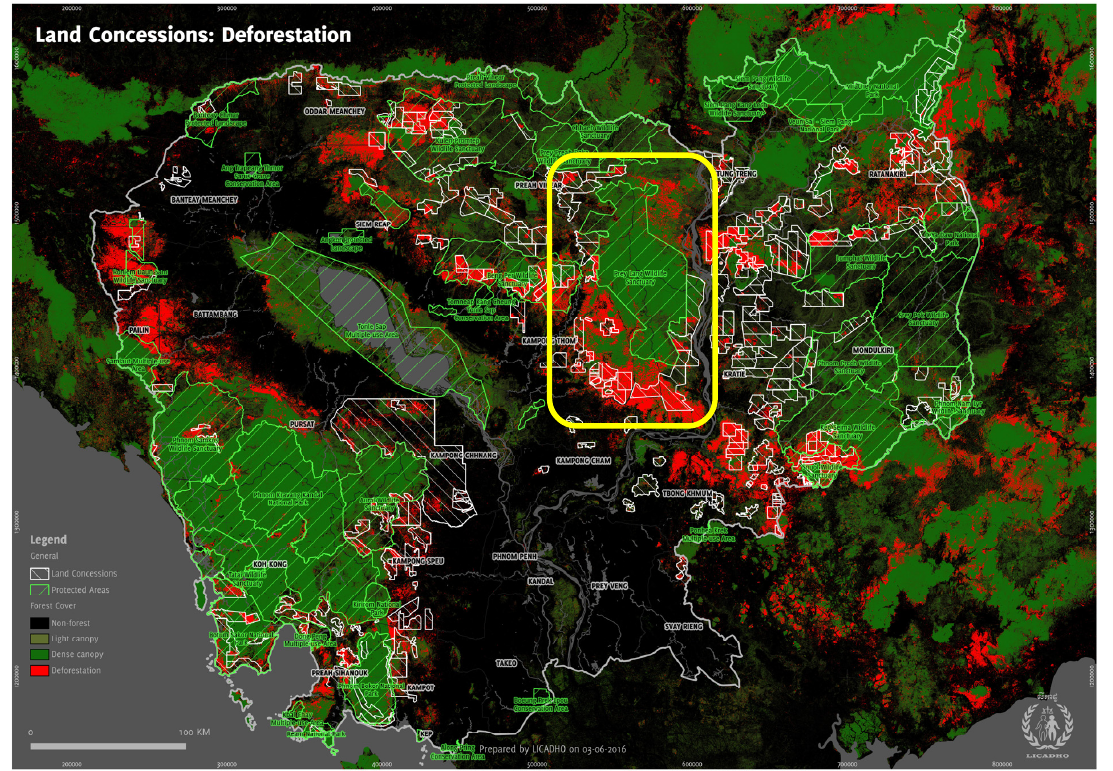
Figure 1. LICADHO (Cambodian League for the promotion and defense of human rights) forest cover map with Economic Land Concession (ELC) and protected area (PA) boundaries, 2016. Forest cover is green, deforestation is red. Green outlines are Protected Areas and white outlines are ELC